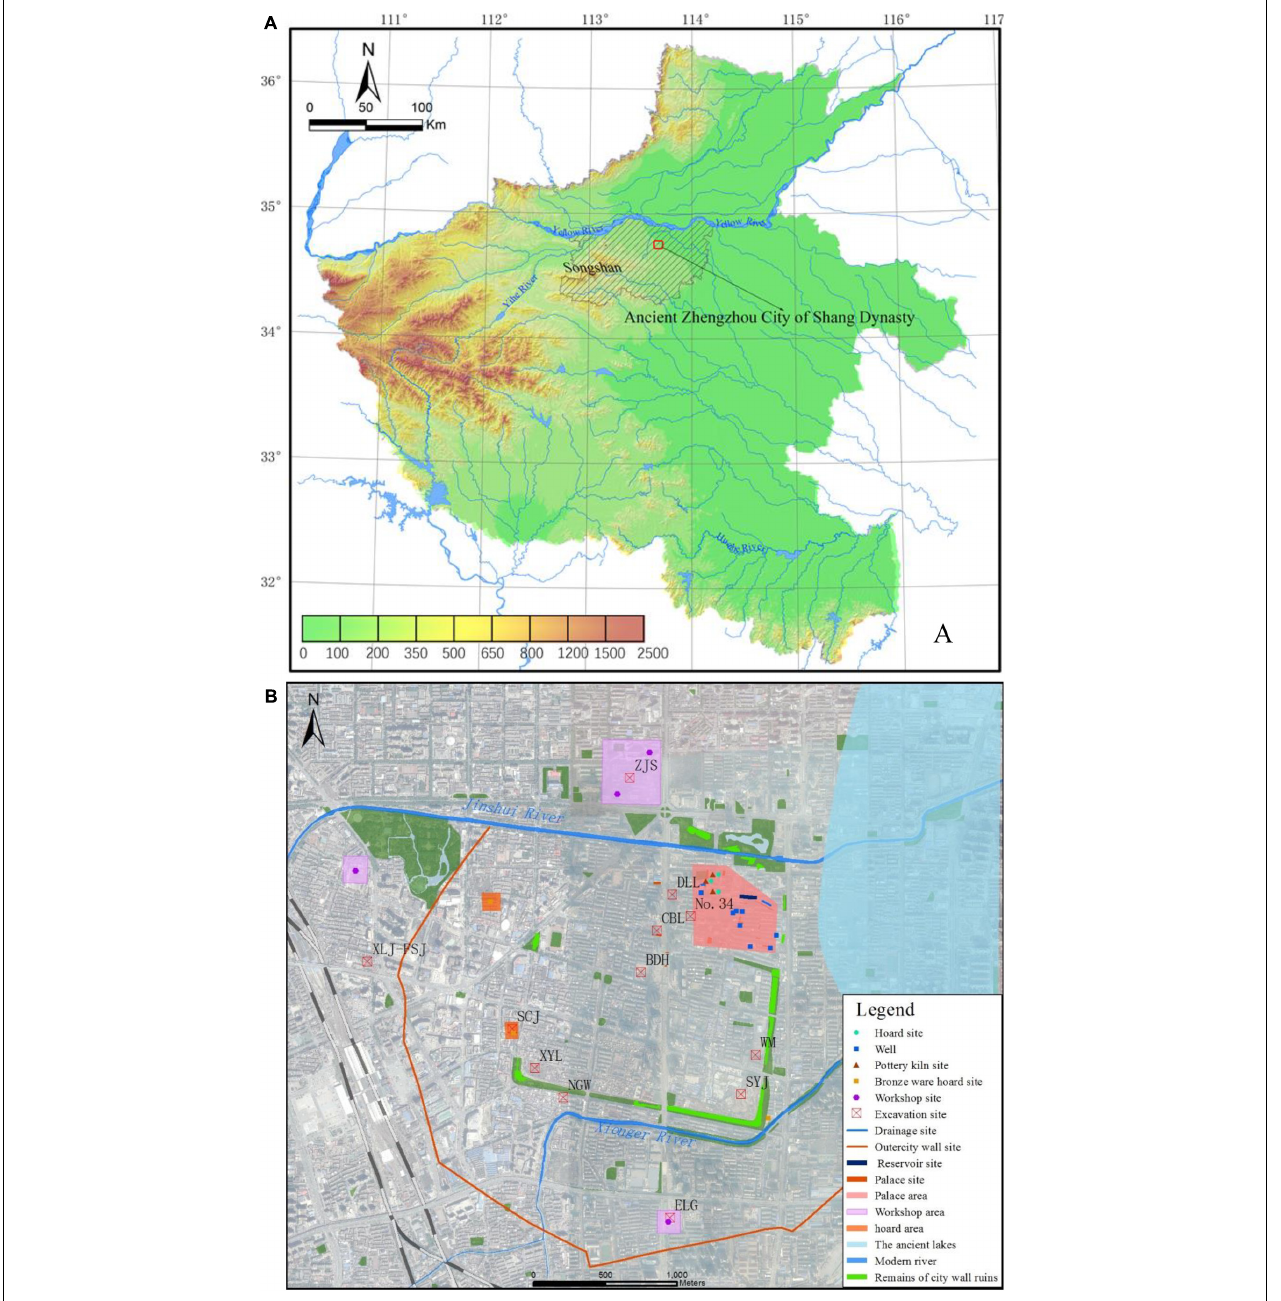
FIGURE 1 | Research area. (A) The location of Zhengzhou Shang city in Henan Province; (B) The layout of Zhengzhou Shang city. The excavation sites in Figure 3 are labeled on this